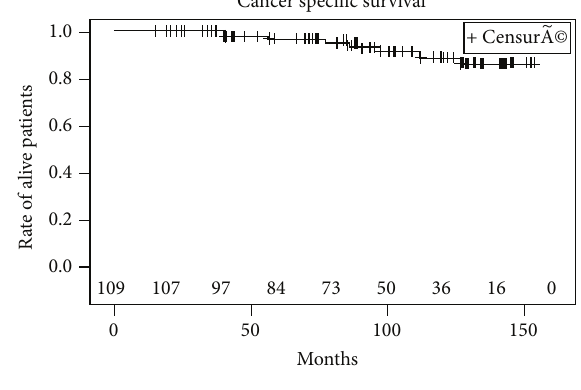
Figure 4: Cancer specific survival.